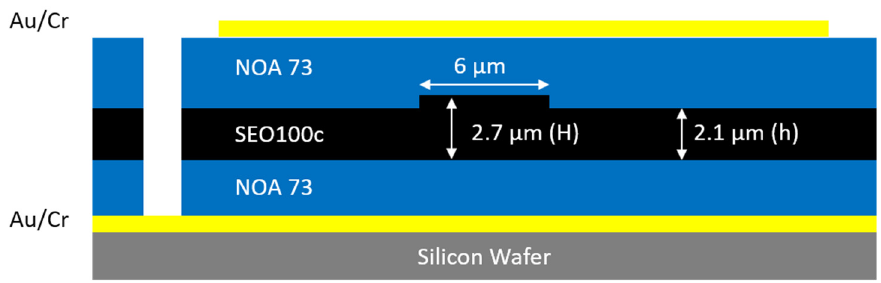
Figure 1. Completed polymer stack for the waveguide devices.